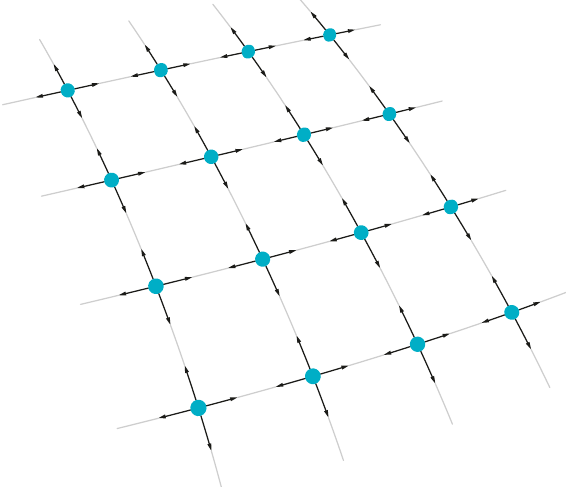
Figure 8: Principle of Hooke’s law spring function.